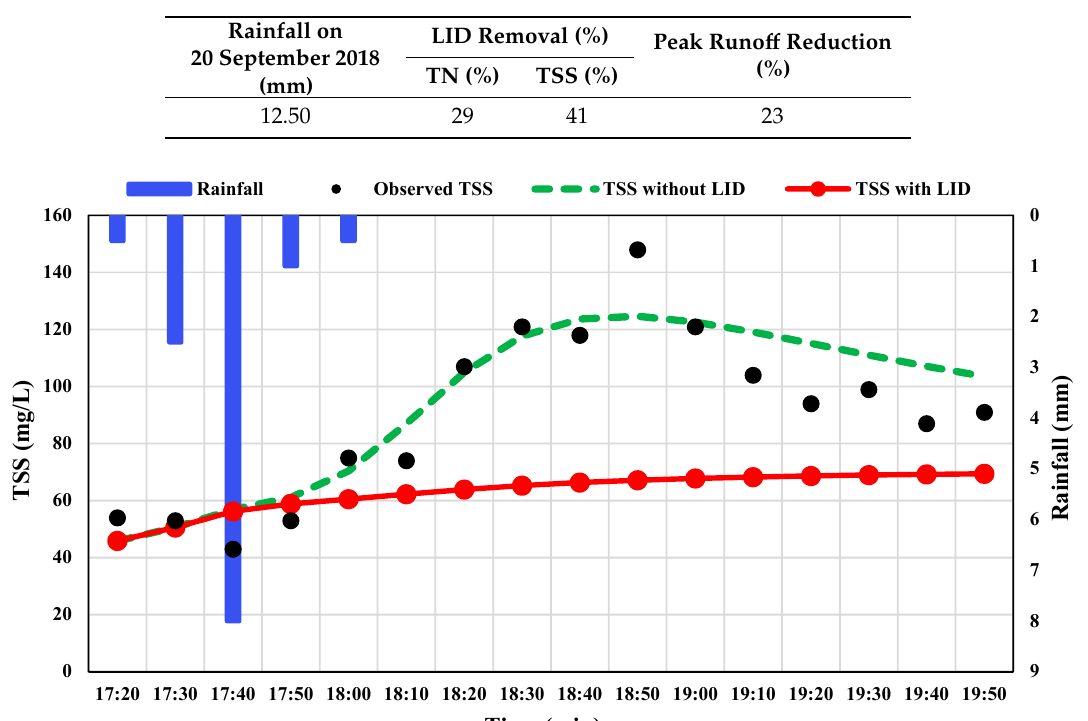
Table 4. Best management practices (BMP) removal and peak runo ff reduction after assigning low impact developments (LIDs) to the model.